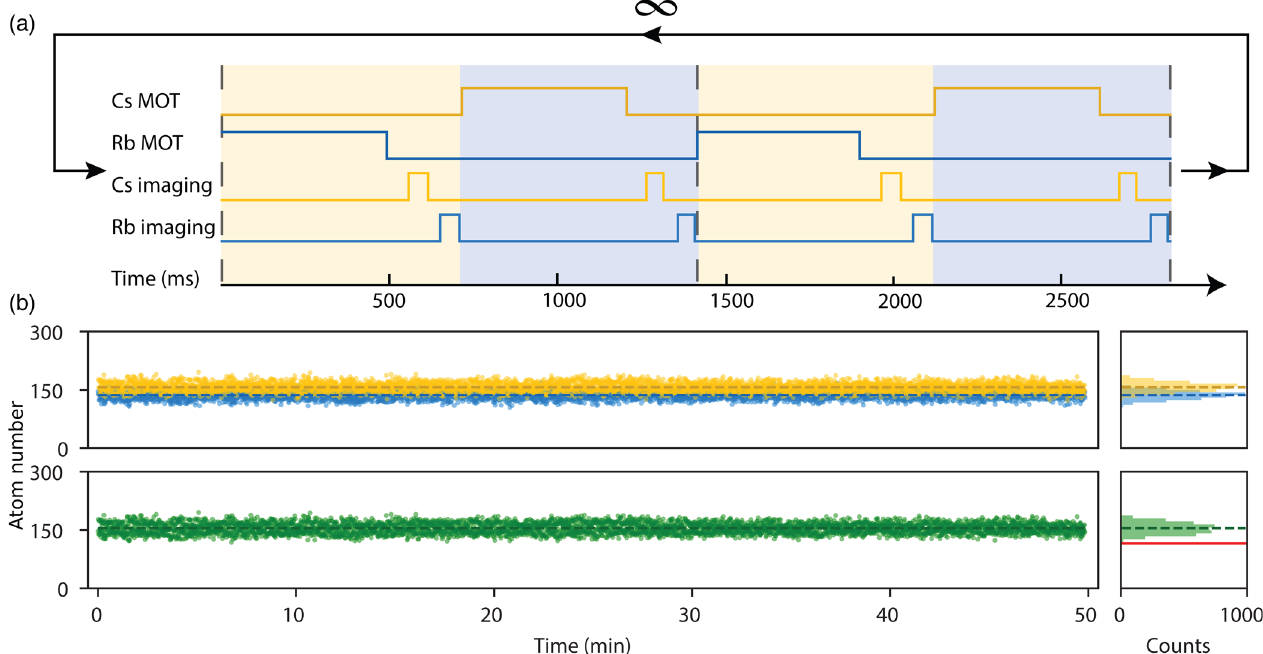
FIG. 4. A continuous-mode atom array. (a) The pulse sequence used to reload the Rb atoms and Cs atoms into the atom array. Rb (Cs) atoms are reloaded into the array while the Cs (Rb) atoms are held in their optical tweezers. The shaded regions, yellow for Cs and blue for Rb, indicate the atomic element available for manipulation or computation during the specified time window. By performing the pulse sequence repeatedly, a continuously available atomic array can be maintained. (b) The number of Rb (blue) and Cs (yellow) atoms in each image from a 50-min data run. The dashed lines indicate the average atom counts. The number of atoms available for manipulation as a function of time (green) indicates that the atom array continuously operates with over 115 atoms (red solid line) at any moment in